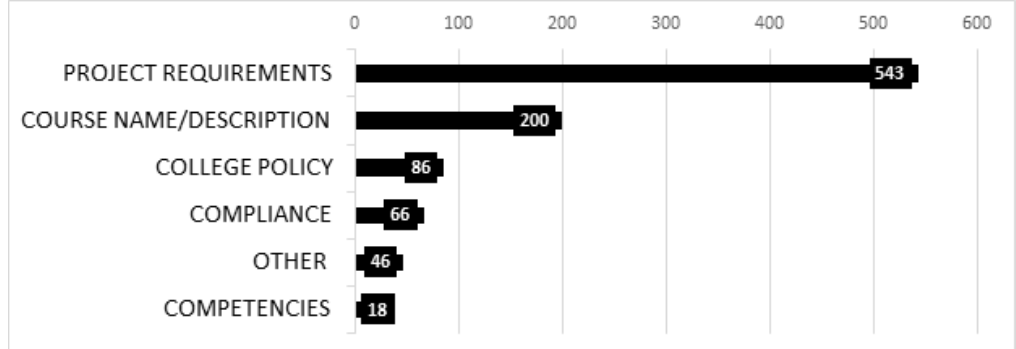
Figure 2 Location of data management within